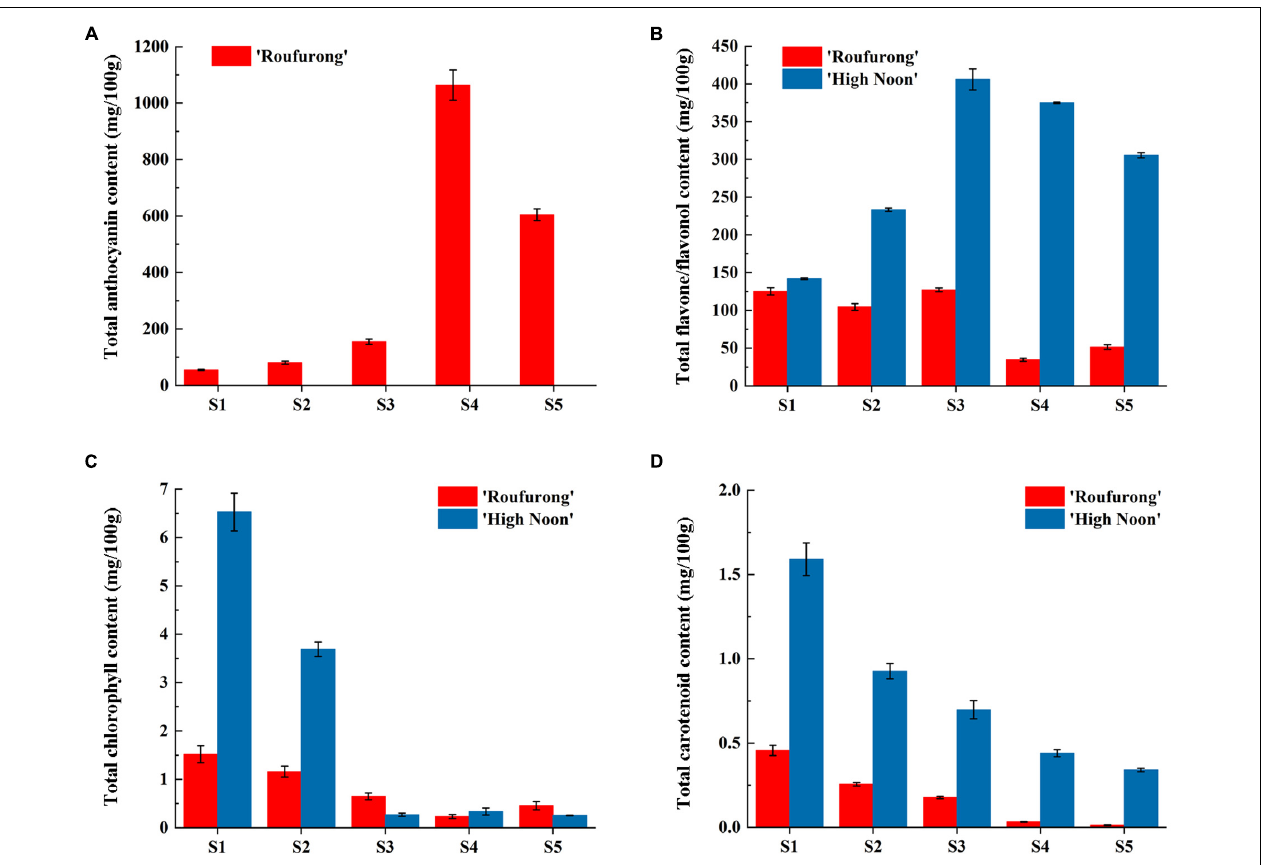
FIGURE 2 | Total anthocyanin (A) , flavone/flavonol (B) , chlorophyll (C) , and carotenoid (D) contents of “High Noon” and “Roufurong.” All the measurements were performed in three biological and three technical replicates. Error bars represent standard deviation of biological and technical